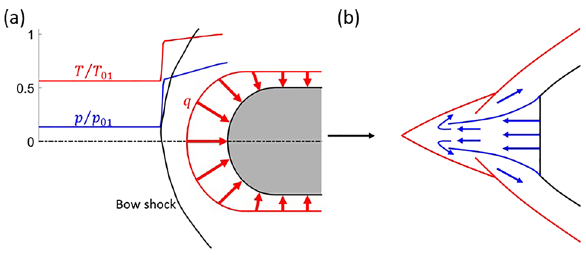
Figure 1. ( a ) Leading edge aerothermal challenge and ( b ) long penetration mode leading edge flow topology sketch, reproduced from Fomin et al. 11